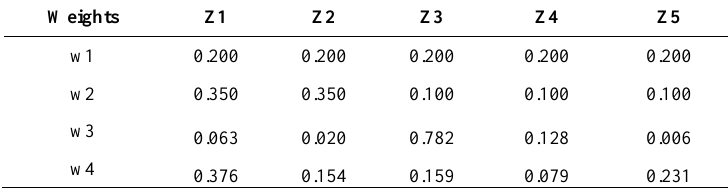
Table 8. Values of weighting indicators (Option 2)